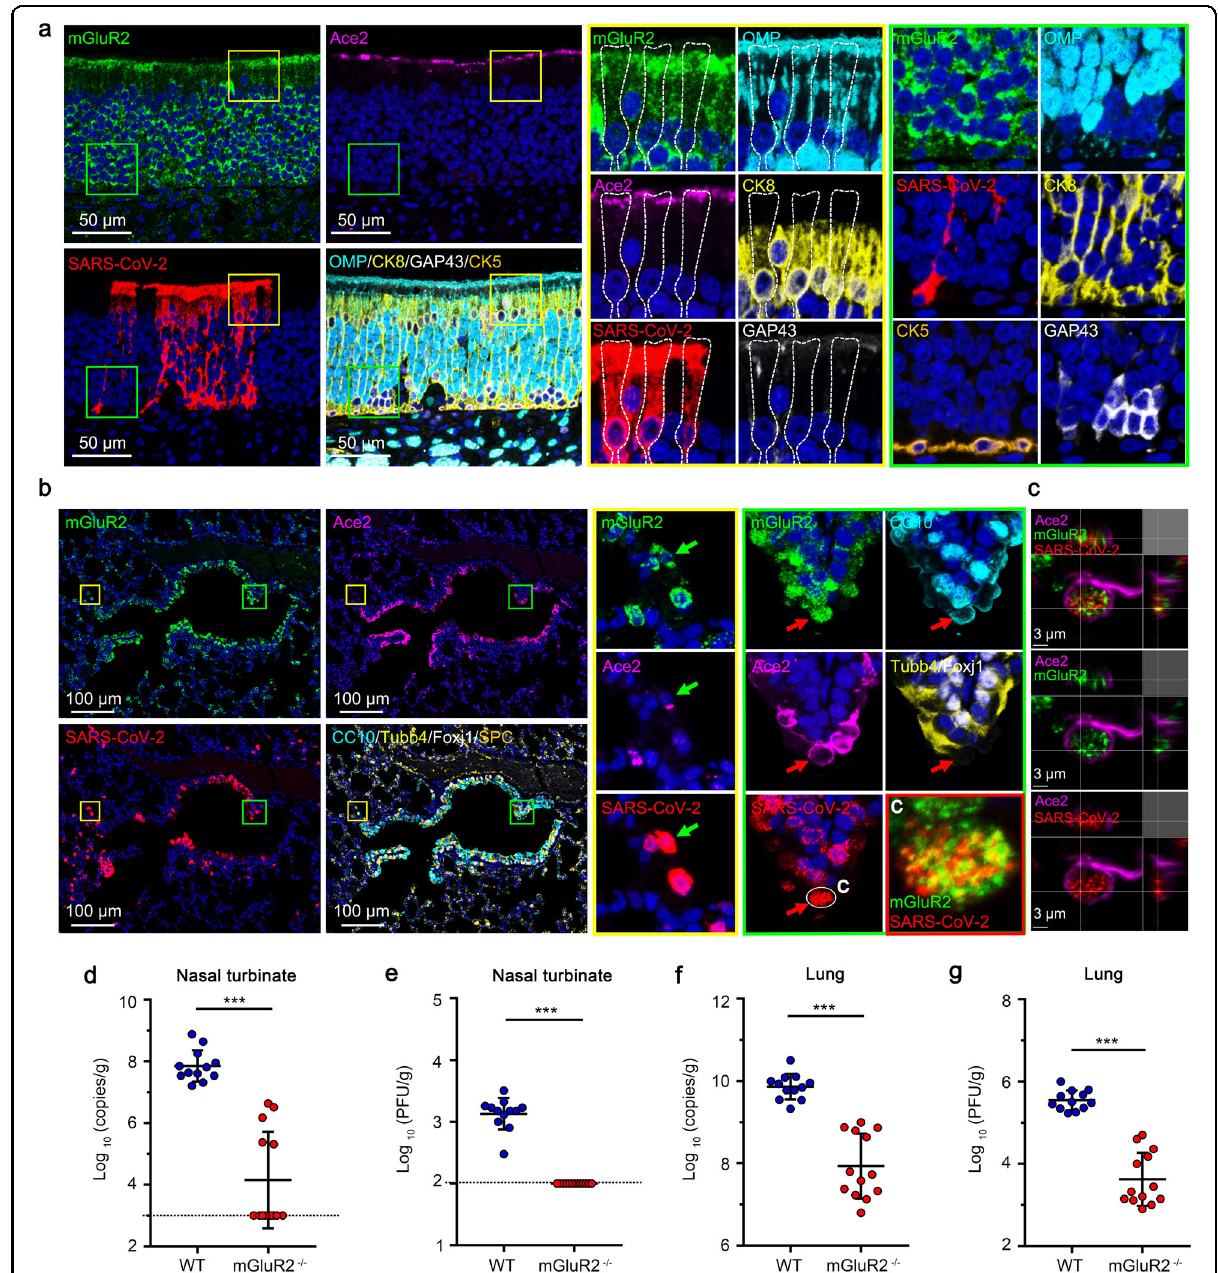
Fig. 5 mGluR2 is important for SARS-CoV-2 infection of mice. a Multiplex immuno fl uorescence staining for the detection of mGluR2-positive cells in olfactory epithelium sections of young mouse infected with SARS-CoV-2 on day 3 p.i.. SARS-CoV-2 N protein (red), mGluR2 (green), Ace2 (magenta), GAP43 (white), CK5 (gold), CK8 (yellow), and OMP (cyan). The yellow and green areas are shown adjacently at a higher magni fi cation, respectively. The dashed box indicates the individual cell boundary. b Multiplex immuno fl uorescence staining for the detection of mGluR2-positive cells in lung sections of young mouse infected with SARS-CoV-2 on day 3 p.i.. SARS-CoV-2 N protein (red), mGluR2 (green), Ace2 (magenta), Foxj1 (white), SPC (gold), Tubb4 (yellow), and CC10 (cyan). The yellow and green areas are shown adjacently at a higher magni fi cation, respectively. The red arrows indicate a mGluR2 + /SARS-CoV-2 + /Ace2 + /CC10 + cell, and the green arrows indicate a mGluR2 + /SARS-CoV-2 + /Ace2 + cell. c The 3D-rendered image was generated by using Imaris software and the co-localization of mGluR2 and SARS-CoV-2 from the two single fl uorescence channels is showed. d – g mGluR2 gene knockout (mGluR2 − / − ) ( n = 13) and WT ( n = 12) mice were infected with HRB26M (150 PFU/mouse), a mouse-adapted SARS-CoV-2 strain, via intranasal inoculation. At 3 days p.i., viral RNA copies and virus titers in the nasal turbinates ( d , e ) and lungs ( f , g ) were determined by use of qPCR ( d , f ) and plaque assays ( e , g ), respectively. The horizontal dashed line indicates the limit of detection. Data represent the sum of three independent experiments ( d – g ), means ± SD, Student ’ s t -test, ***P <